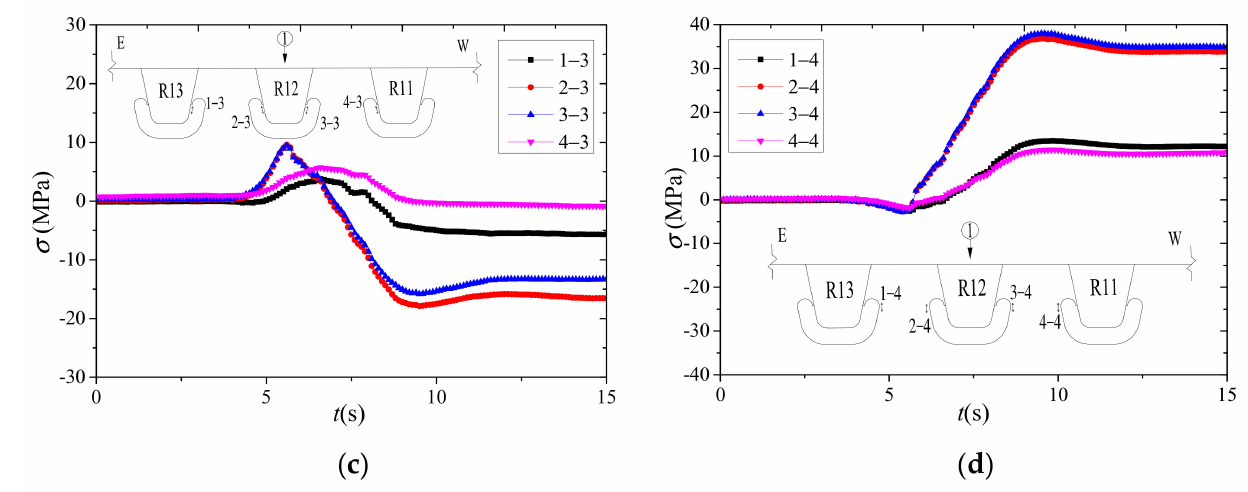
Figure 6. Strain gauge records under LC1 loading cases. ( a ) RF-R; ( b ) RF-F; ( c ) RF-W; ( d ) Cutout.